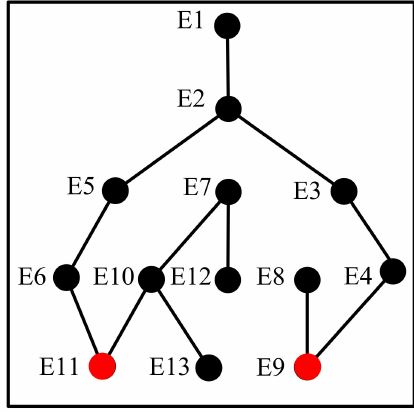
Figure 17. Failure restoration results using the proposed radial constraints modeling